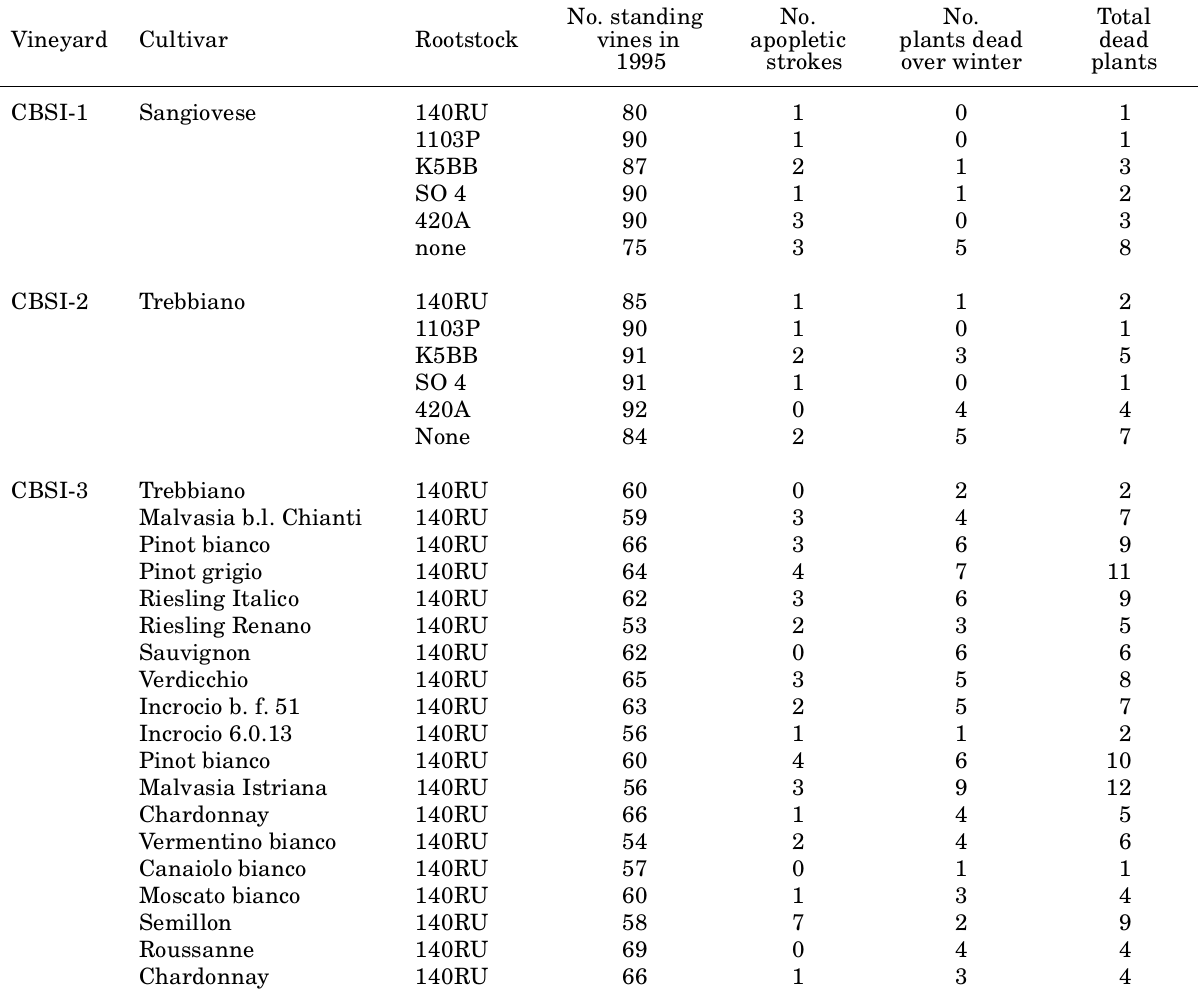
Table 4. Number of vines inspected in vineyards CBSI-1, CBSI-2 and CBSI-3 in the period 1995-1999 that exhibited apoplexy or did not revegetate after winter dormancy although they had not exhibited any external esca symptoms in the preceding year or